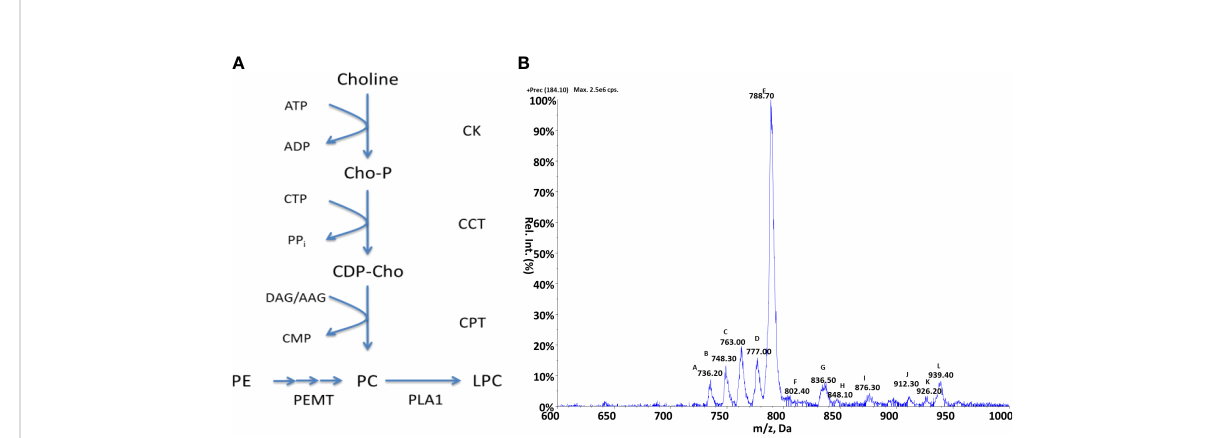
FIGURE 3 Choline metabolism in Crithidia (A) An overview of PC metabolism in eukaryotes. Key - CCT, Choline-phosphate cytidylyltransferase; CK, Choline kinase; CPT, Choline phosphotransferase; PEMT, Phosphatidylethanolamine N-methyltransferase; PLA1, Phospholipase A1; AAG, alkyl- acylglycerol; ADP, adenosinediphosphate; ATP, adenosine-triphosphate; CDP-Cho, cytidine diphosphate-choline; CMP, cytidine monophosphate; CTP, cytidine-triphosphate; DAG, diacylglycerol; Cho-P, choline phosphate; LPC, lyso-phosphatidylcholine. (B) ESI-MS-MS positive parent ion scan of PC lipids from C. fasiculata lipid extract, scanning for m/z 184. Peaks are plotted as their relative intensity (%) to that of the largest peak in the spectrum and in terms of their mass to charge (m/z) ratio. Species identities are given in Table